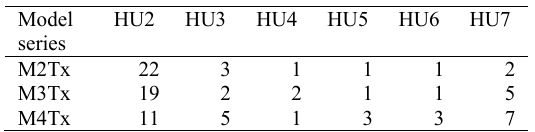
Table 1: The numbers of hidden units (HU) at